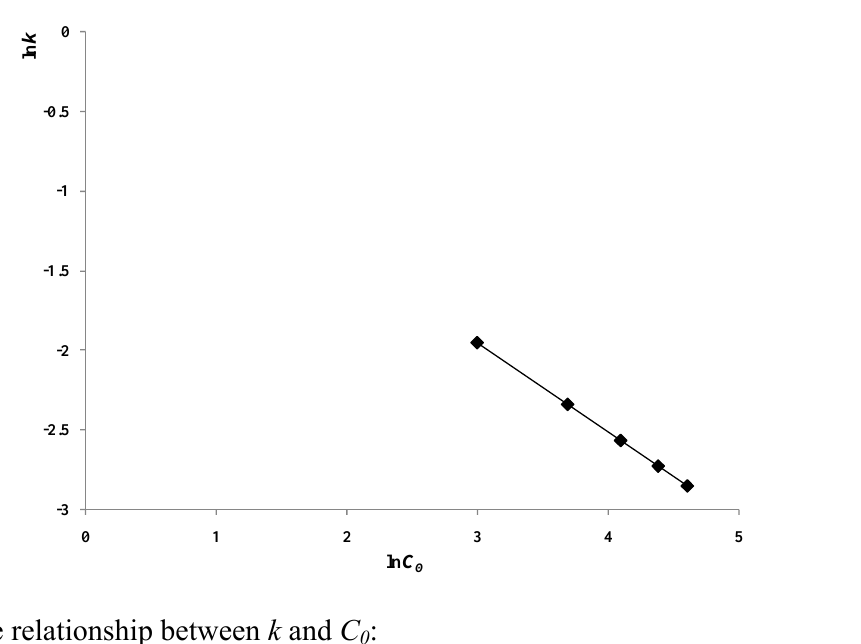
with various initial 2,4-D concentrations 0